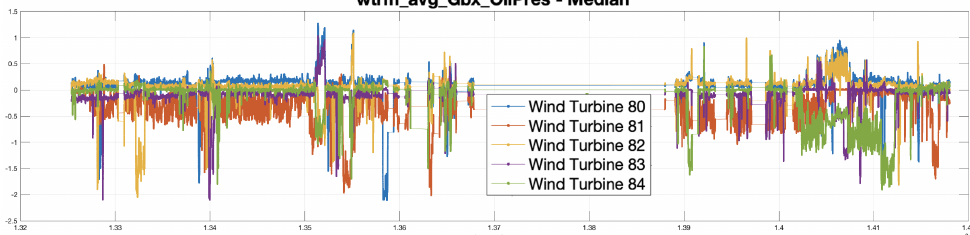
Figure 12. At the top, an overlaid representation of the residues obtained from the signal wtrm_avg_Gbx_OilPress corresponding to each of the analysed turbines (WT80–WT84) for the tem- poral intervals in which the SCADA system has been operating. At the bottom, the same signals smoothed by a 50-sample moving average